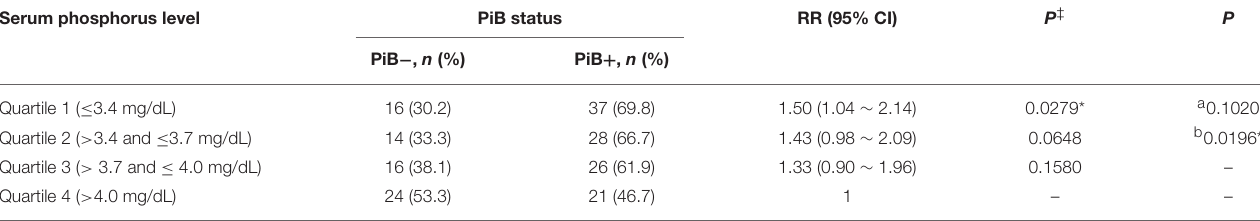
TABLE 2 | Relationship between serum phosphorus and risk of cerebral amyloid deposition in cognitively impaired subjects. Serum phosphorus level PiB status RR (95% CI) P ‡